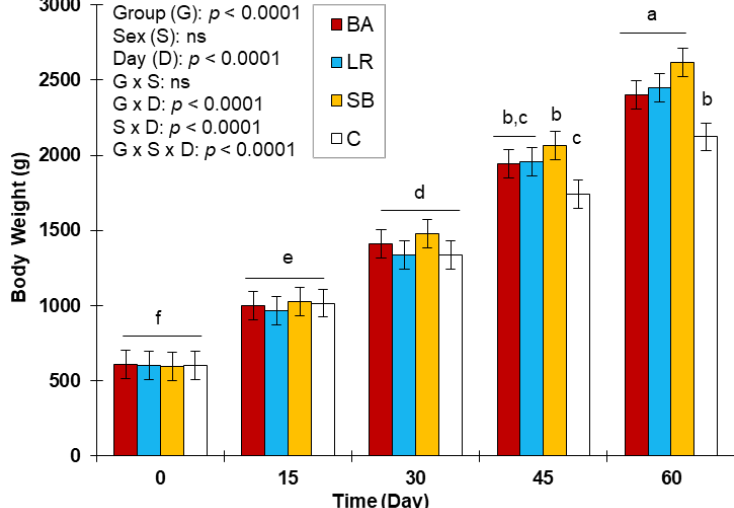
Figure 1. Effects of dietary supplementation with probiotics on live body weight (g) of healthy rabbits. (C): control group, (BA): Bifidobacterium animalis subsp. Lactis BB-12 group, (LR): Lactobacillus rhamnosus GG group, (SB): Saccharomyces boulardii CNCM I-745 group. LS-means (± SD) with different superscripts (a, b, c, d, e, f) are significantly different ( p < 0.05)